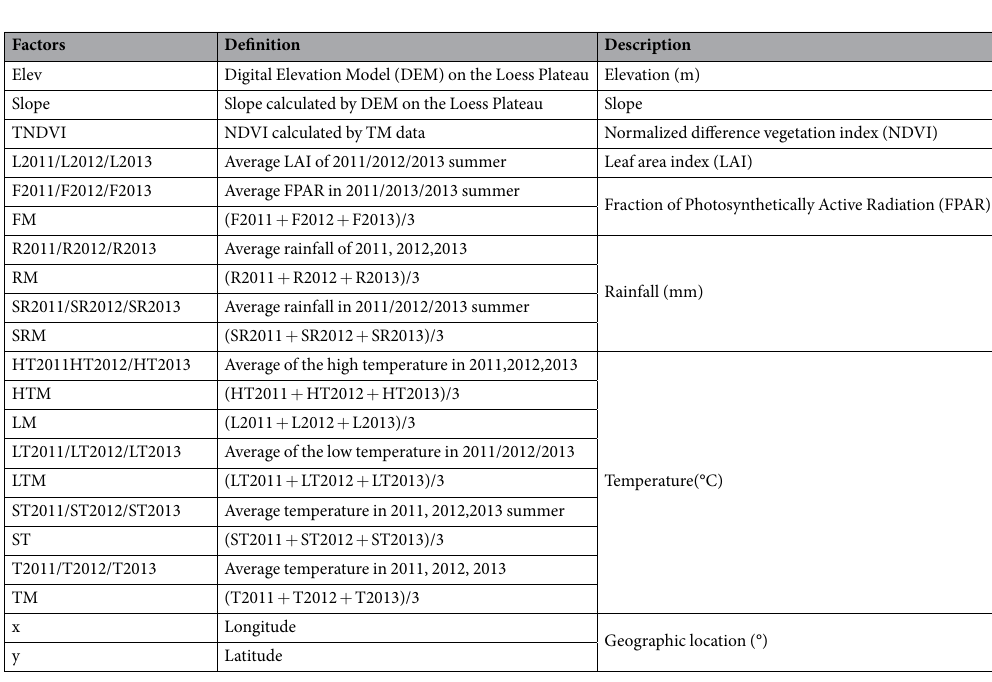
Table 2. Variable definitions in this study.